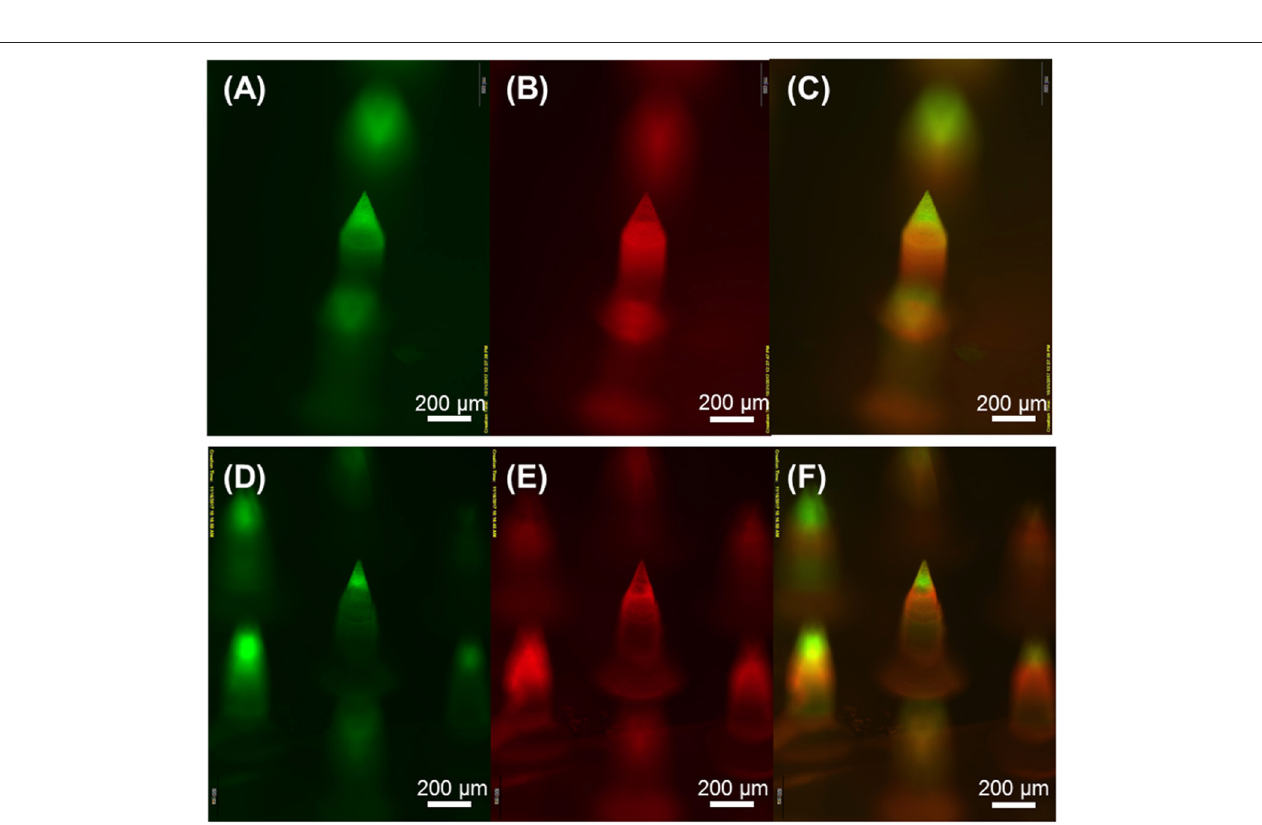
FIGURE 5 | Fluorescence microscopy images of horizontally layered microneedles. Green and red fluorescence corresponds to coumarin 314-containing PLGA and SRB-containing PVP layer, respectively. (A,D) show PLGA microneedle tips, (B,E) show PVP needle shafts, and (C,F) are overlay images. Scale bars represent 200 µ